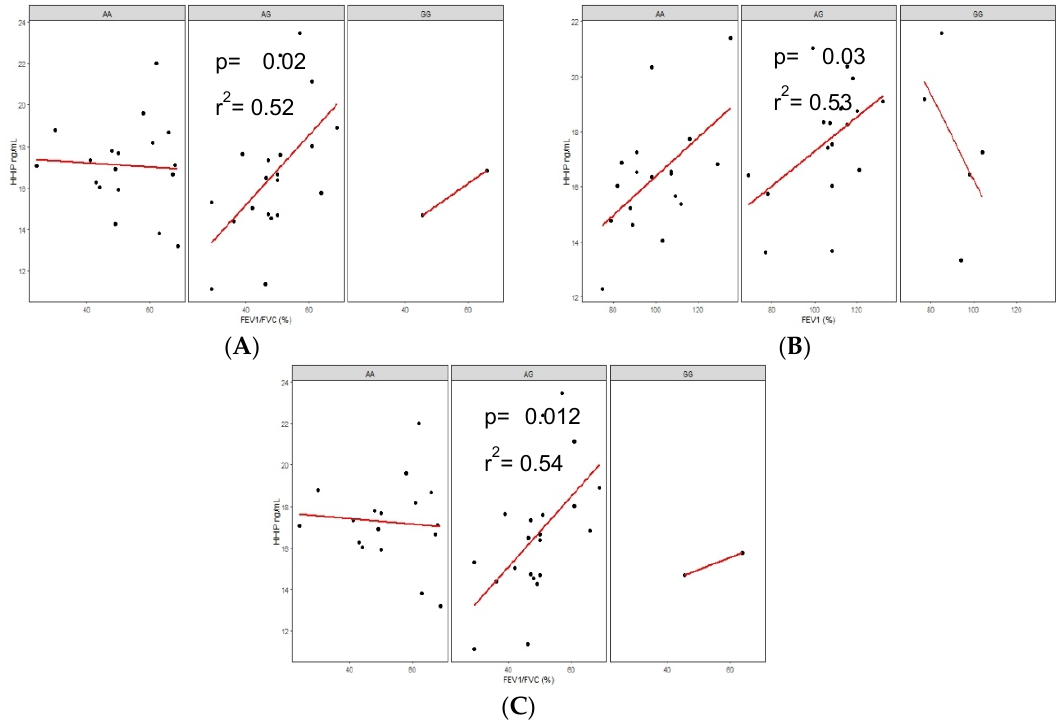
Figure 4. Correlations of protein levels and lung function. ( A ) correlation of FEV 1 /FVC and protein levels in heterozygous (AG) BBES group of the rs1828591; ( B ) correlation of FEV 1 and protein levels in heterozygous (AG) BBES group; and ( C ) correlation of FEV 1 /FVC and protein levels in heterozygous (AG) COPD ‐ BS group, both in the rs13118928.